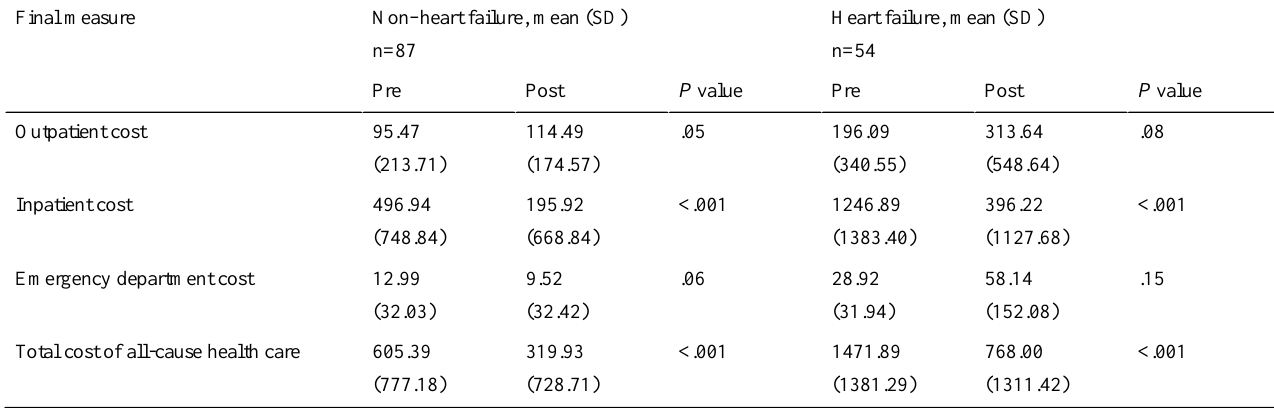
Table 5. Monthly average cost per patient (in US$) 6 months before (pre) and 6 months after (post) initiation of telehealth services in patients with cardiovascular diseases, stratified according to heart failure